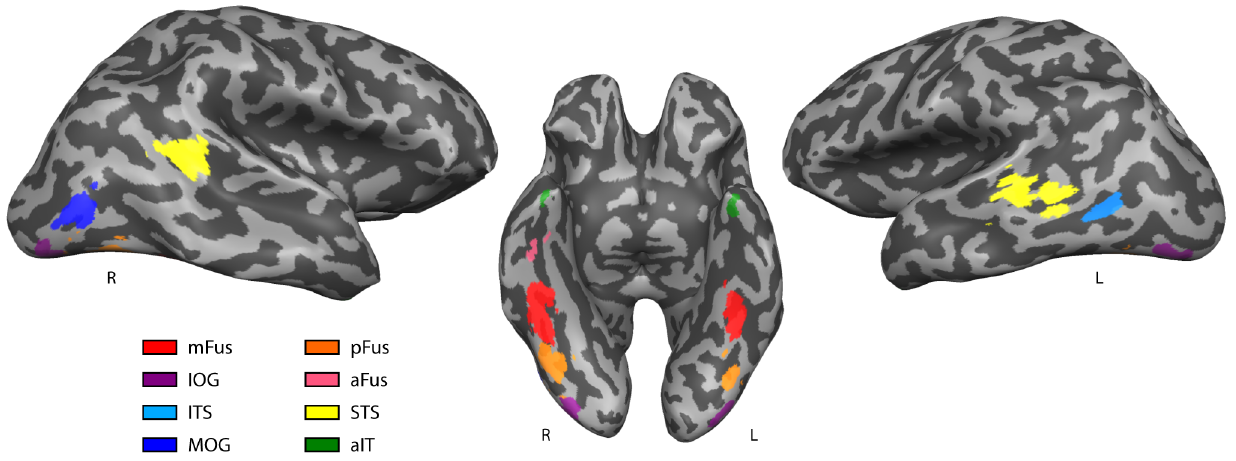
Figure 1. Face-selective regions of interest (ROIs). Regions of interest identified with fMRI using the contrast faces . objects in a representative participant thresholded at q , .05. Each region is shown on a partially inflated cortical surface in a unique color (see legend).